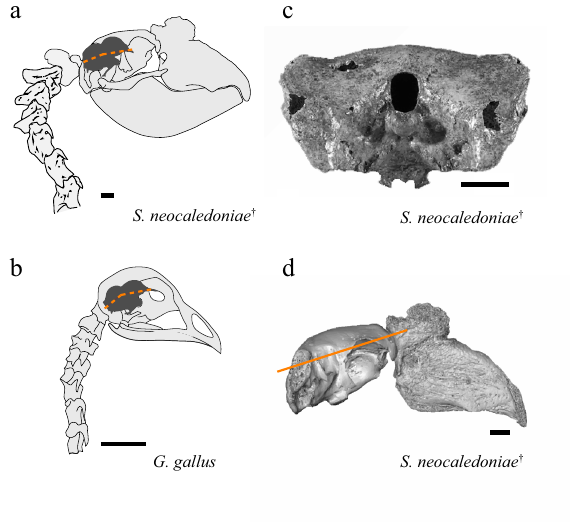
Figure 2. Carriage of the head and orientation of the endocranial axis in Sylviornis neocaledoniae ( a ) contrasted with that in Gallus gallus ( b ). The endocranial cavity and endocranial axis (orange dashed lines) are superimposed on lateral views of the head and neck in the two species. The attachment of the neck to the back of the skull in S. neocaledoniae is accompanied by a dorsally positioned foramen magnum ( c ) and particular orientation of the skull ( ∽ 15°) relative to the horizontal (orange line, d ). Scale bars = 2